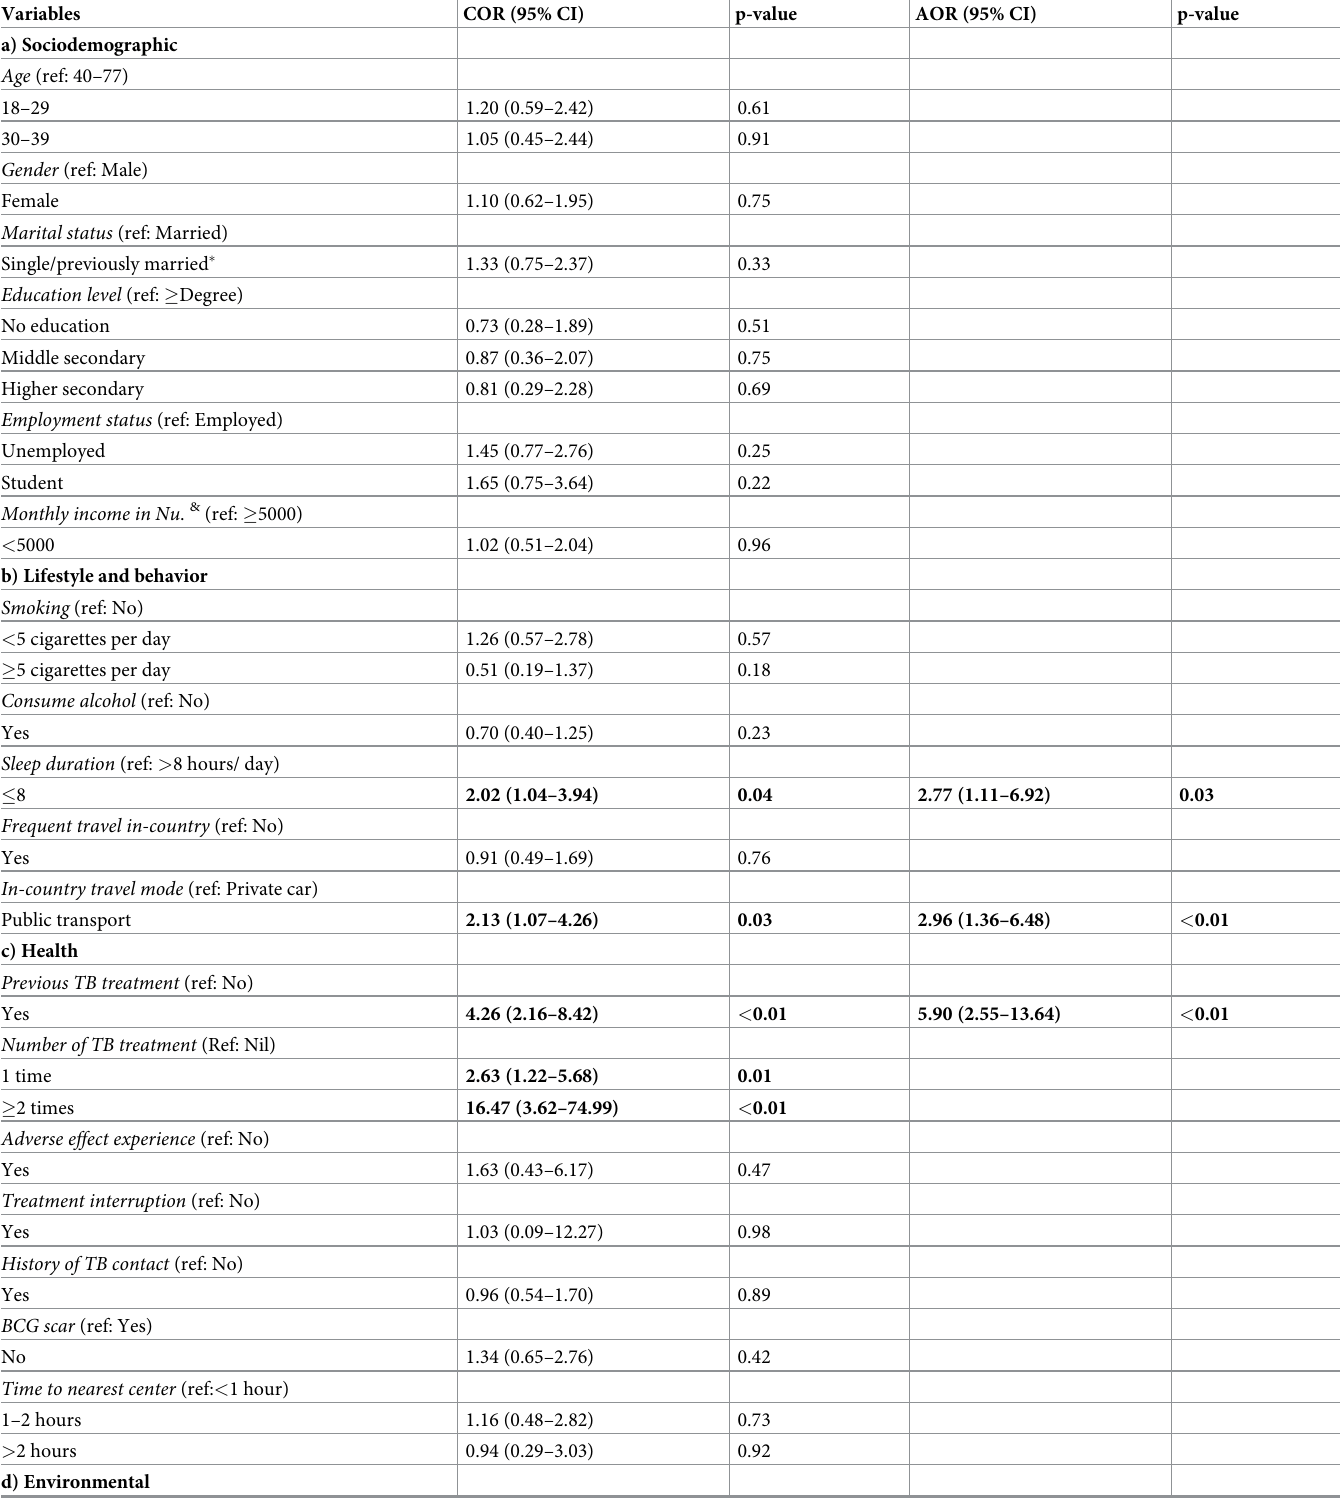
Table 2. Bivariate and multivariable analysis of risk factors associated with